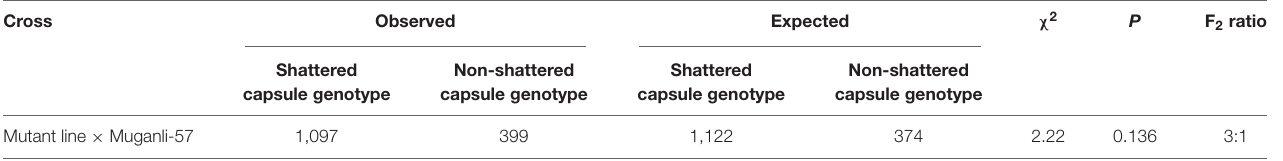
of 697.3 cM, with the LGs ranging from 14.2 to 109.9 cM, with an average marker interval of 0.89 cM. The LG with the greatest number of markers was LG8, which included 125 markers, with an average distance of 0.73 cM. Conversely, LG11 had the fewest markers, had the lowest marker density (4.73 cM), and was also the shortest LG. LG13, the longest LG, had a genetic length of 109.90 cM and contained 97 markers, with an average distance between markers of 1.13 cM. The highest marker density was observed in LG6 (an average of 0.38 cM between markers), followed by LG1 (0.62 cM) ( Table 4 ); the average distance between markers was under 1 cM in seven LGs ( Table 4 ). The largest gap was of 16.54 cM, located in LG7, followed by 16.46- and 13.24-cM gaps in LG3 and LG9, respectively.